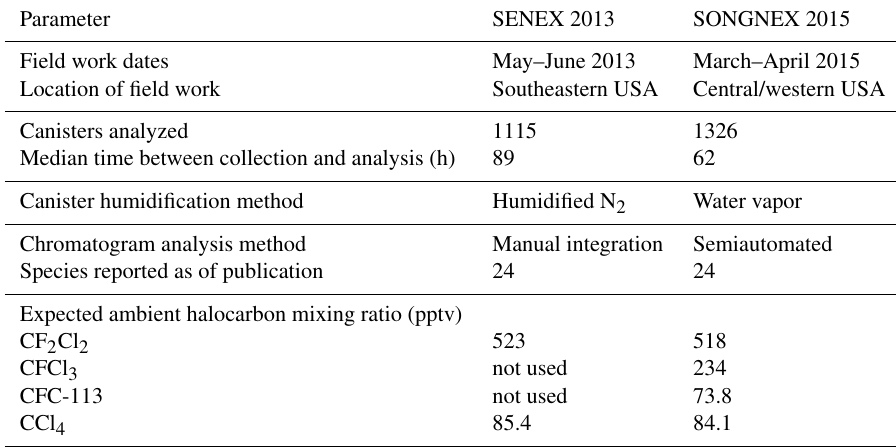
Table 1. Summary of measurement parameters for SENEX 2013 and SONGNEX 2015